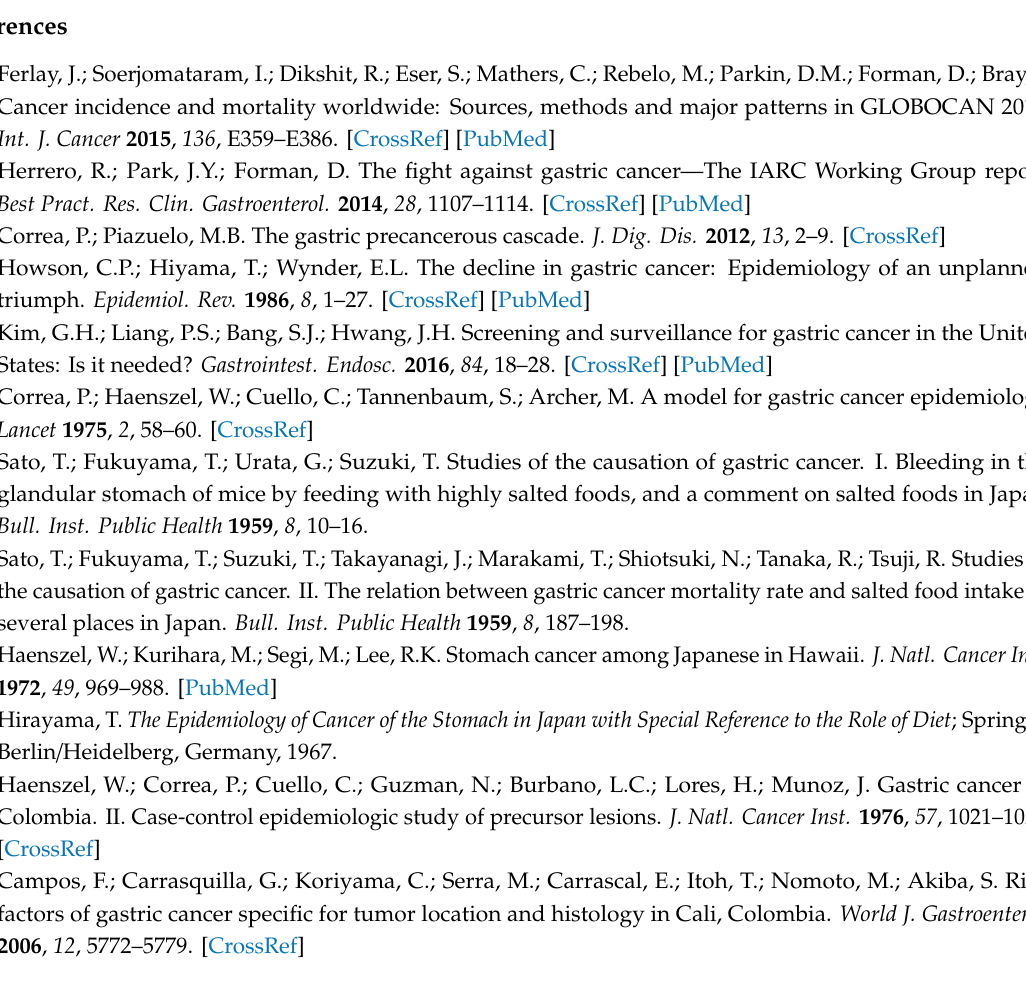
Figure S1: Sample Derivation Flowchart, Table S1: Adjusted risk ratios for the association between salt intake at five months defined by urinary sodium / creatinine ratio and progression in the gastric precancerous process (11–12 years compared to five months), Table S2: Crude risk ratios for the association between salt intake at baseline, measured by urinary sodium creatinine ratio and progression in the gastric precancerous process (11–12 years compared to baseline), Table S3. Crude risk ratios for the association between salt intake at baseline, measured by sodium creatinine ratio and progression in the gastric precancerous process (11–12 years compared to five months), Table S4: Adjusted risk ratios for the association between salt intake at baseline, measured by the frequency of adding salt to foods, and progression in the gastric precancerous process (11–12 years compared to baseline), Table S5: Adjusted risk ratios for the association between salt intake at baseline, measured as total salt added to food, and progression in the gastric precancerous process (11–12 years compared to